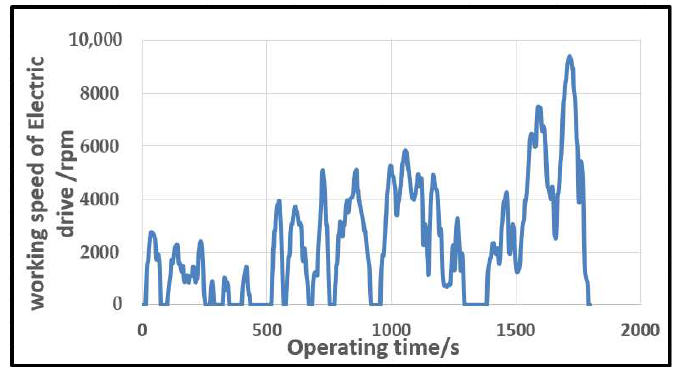
Figure 2. Motor speed versus time.